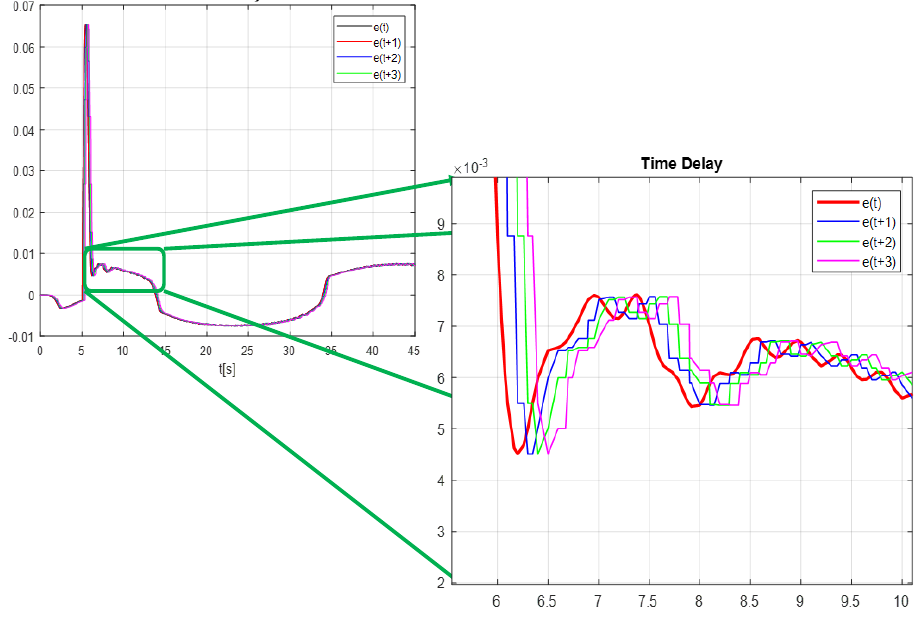
Figure 20. Time delay e ( t ) , e ( t + 1 ) , e ( t + 2 ) , e ( t + 3 )